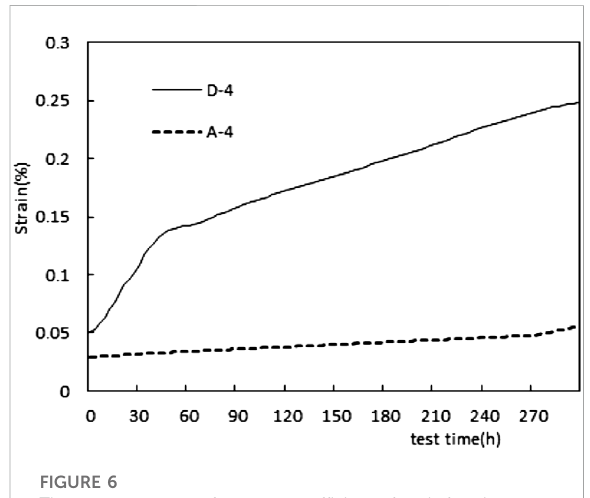
FIGURE 6 The response curves for creep coef fi cient of rock-forming minerals.